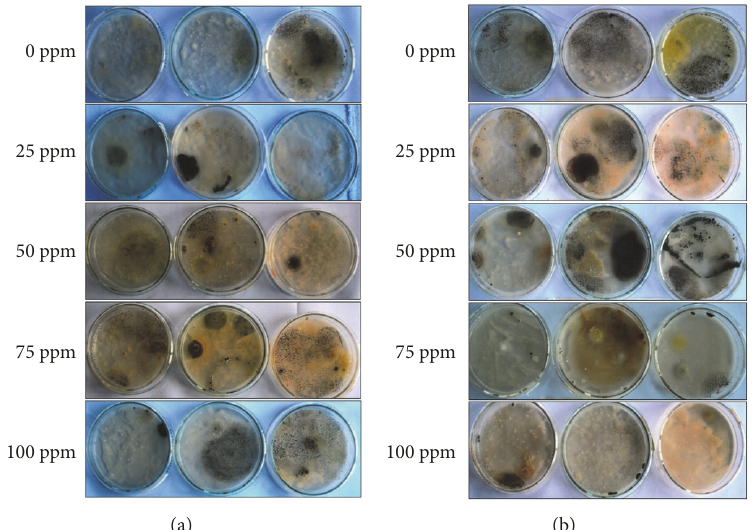
Figure 1: Seven-day-old fungal colonies from (a) water samples and (b) sediment samples isolated on PDA plates with 0 ppm, 25 ppm, 50 ppm, 75 ppm, and 100 ppm Cd concentrations.